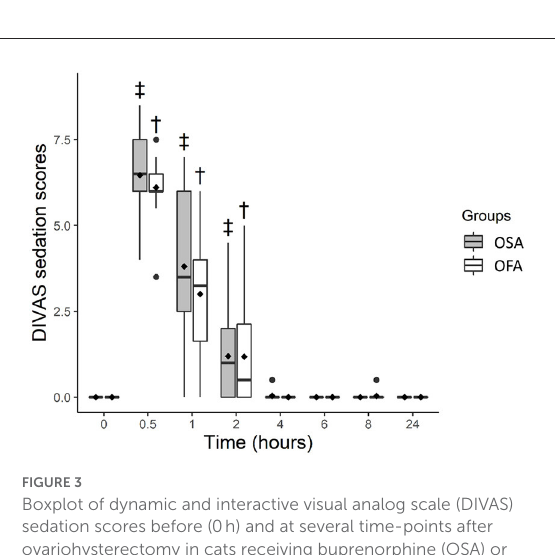
FIGURE3 Boxplot of dynamic and interactive visual analog scale (DIVAS) sedation scores before (0h) and at several time-points after ovariohysterectomy in cats receiving buprenorphine (OSA) or saline (OFA) by the intramuscular route in combination with ketamine-dexmedetomidine-midazolam and multimodal analgesia. • indicates outliers; (cid:7) indicates mean; † indicates significant difference in OFA when compared with baseline; ‡ indicates significant difference in OSA when compared with